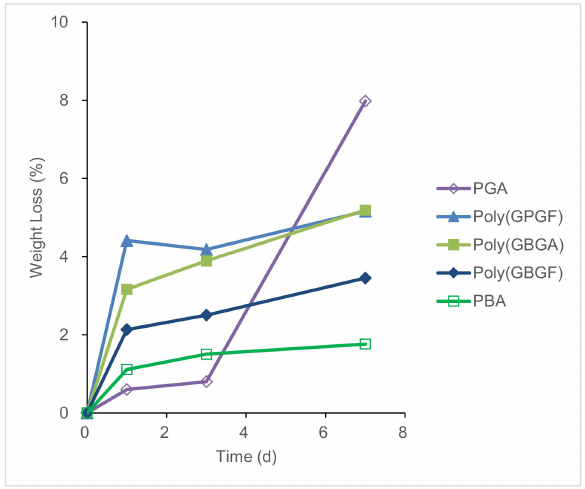
Figure 5. Hydrolytic degradation of the homo- and copolyesters at 45 ◦ C. Table 5. Differences in hydrolysis degree between the first day and the seventh day. Differences in Weight Loss between the First Day and Seventh Polymer